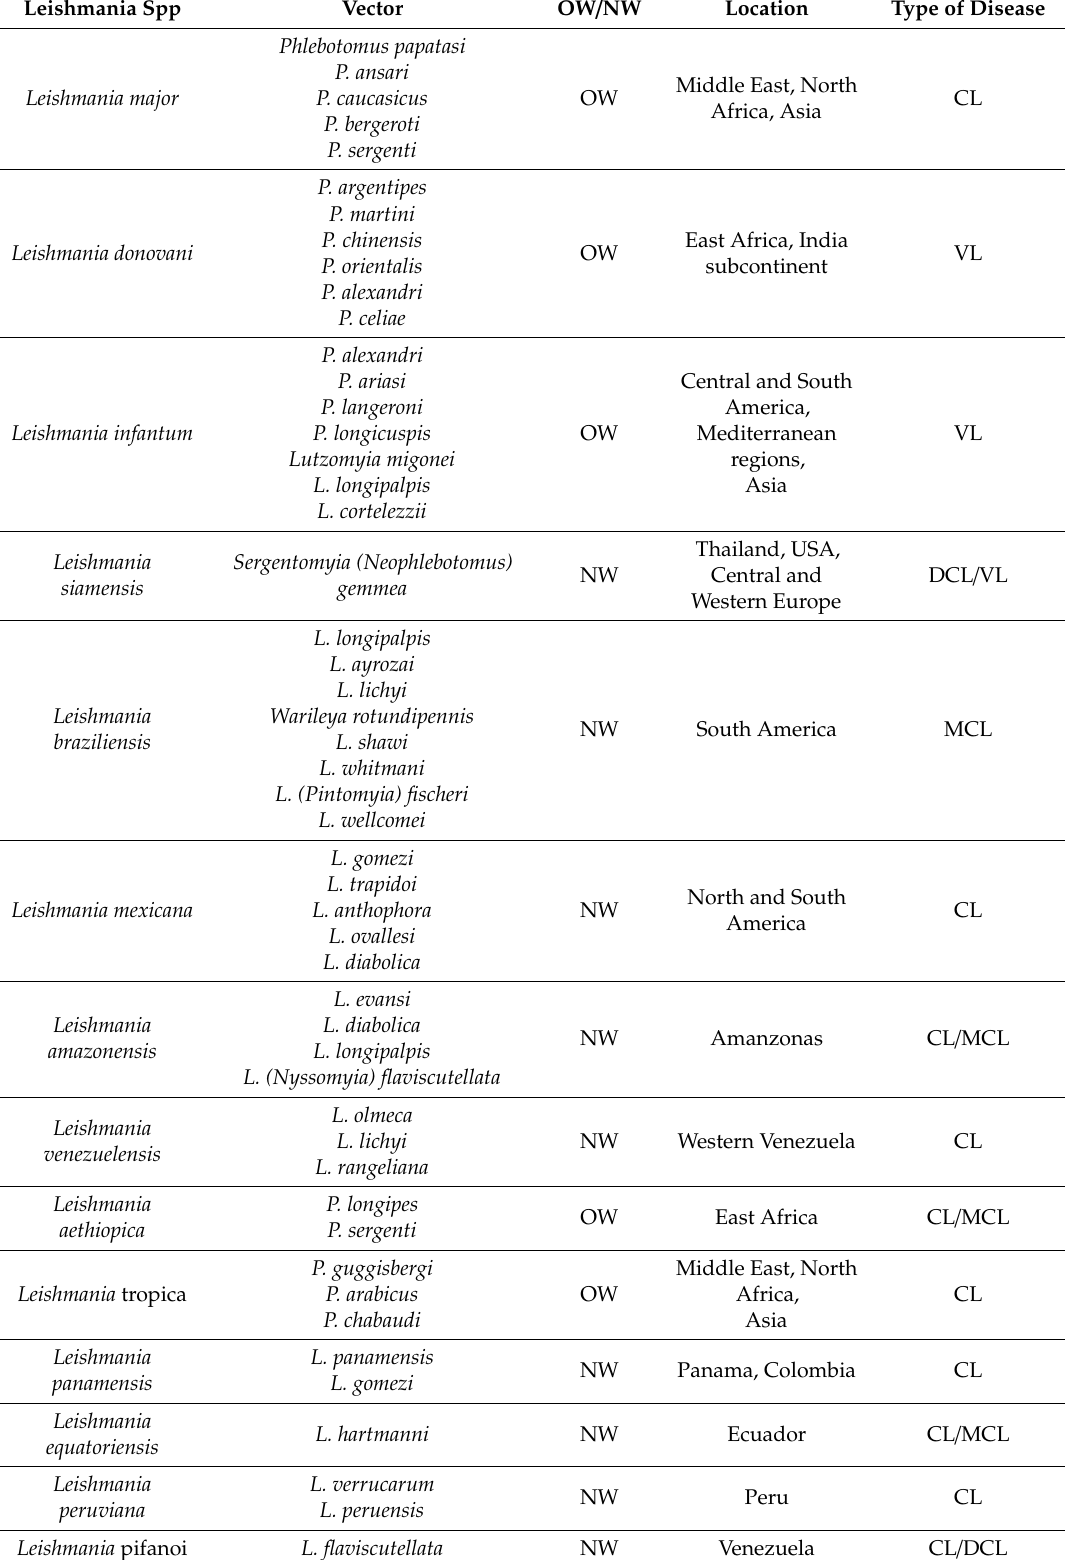
Table 1. Di ff erent Leishmania species and their geographical location and